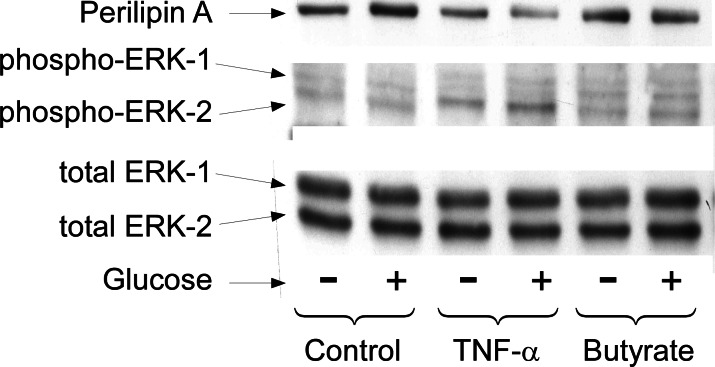
Effect of butyrate on MAPK and perilipin.3T3-L1 adipocytes were treated with or without 25 mM glucose and 50 ng/ml TNF-α or 5 mM butyrate for 24 h. Total protein extracts were prepared and Western blots were performed with antibodies raised against (A) perilipin (approx 57 kDa), (B) phosphorylated MAP Kinase or (C) total MAP Kinase (ERK 1 and 2 ran at approx. 44 and 42 kDa, respectively). Data depicted are representative of three or more independent experiments.